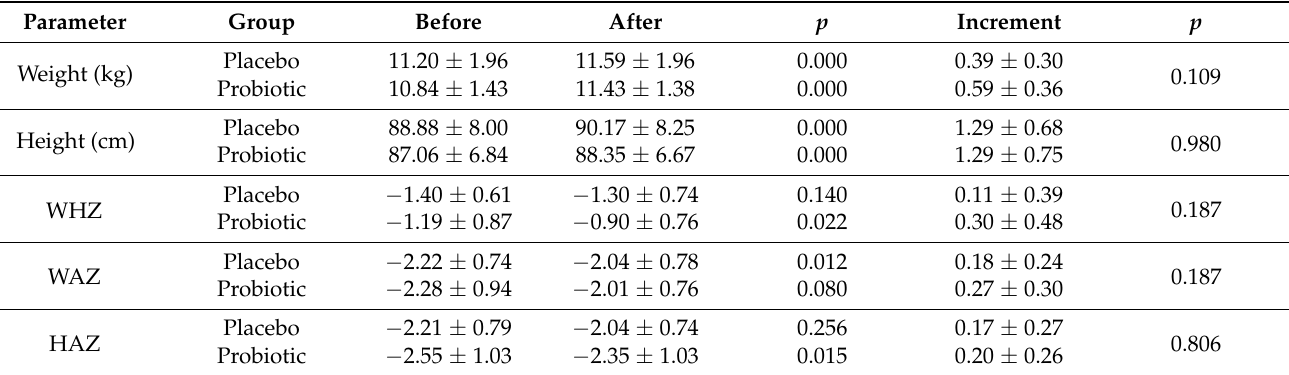
Table 4. Anthropometry and nutritional status of the placebo and probiotic groups before and after the intervention.